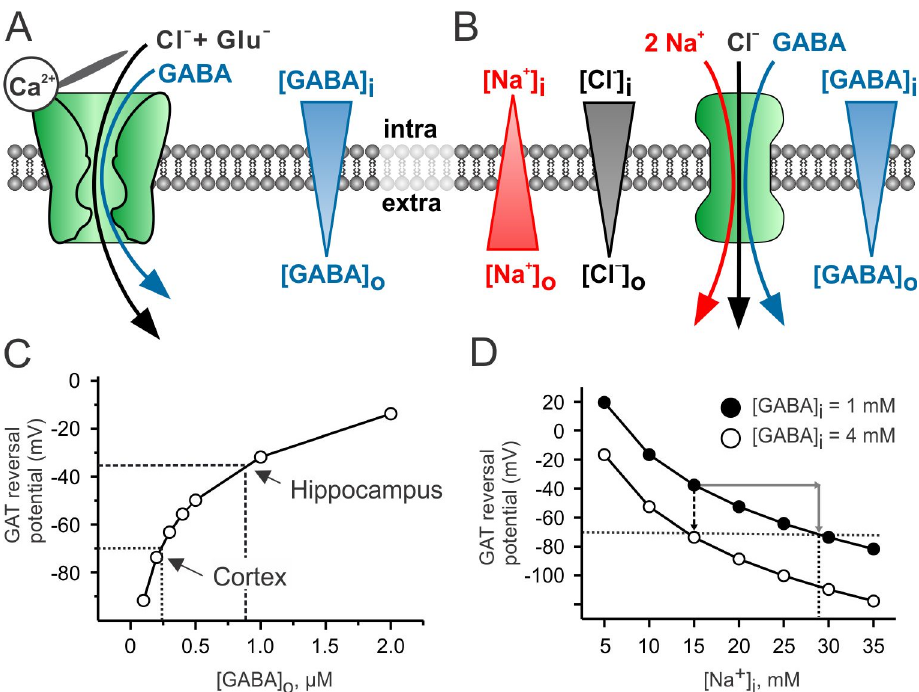
Figure 2. Possible pathways of GABA release from astrocytes. ( A ) GABA can be released via a Ca 2+ -activated anion channel (for example Bestrophin 1, Best1, [23]). The driving force for GABA release is the transmembrane GABA gradient. Best1 opening and conductance is controlled by [Ca 2+ ] i . Note that Best1 is also permeable for Cl − and glutamate. ( B ) GABA transporter (GAT3) op- erating in reverse mode can release GABA [20]. In addition to the GABA gradient, the transmem- brane gradients of Na + (quadratic impact) and Cl − determine the electromotive driving force and, in turn, the direction of GABA transport. ( C ) The GAT reversal potentials depend on the [GABA] o . To calculate GAT reversal potential, following values have been taken: [Na + ] o = 140 mM, [Cl − ] i = 135 mM, [Na + ] i = 15 mM, [Cl − ] i = 40 mM, and [GABA] i = 1 mM. The reported [GABA] o of 0.2 µM in the cortex [40] and 0.8 µM in the hippocampus [41] favor the GAT3-mediated release under resting conditions in the former (GAT rev ~ − 70 mV) but not in the la tt er (GAT rev ~ − 35 mV). ( D ) To change the direction of GAT-mediated transport in the hippocampus, either [Na + ] i has to be increased to about 25–30 mM (gray arrow; for instance, as a result of EAAT-mediated glutamate uptake [21]) or [GABA] i , it has to be elevated to about 4 mM (dashed arrow) [28].